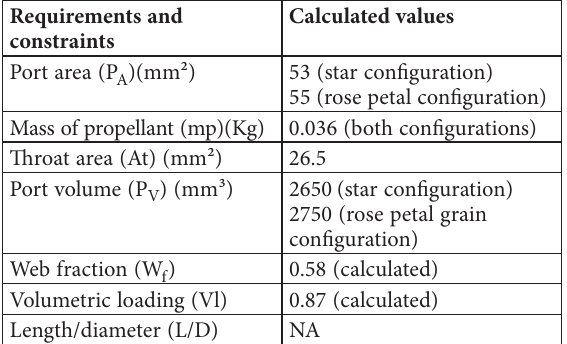
Table 2. Calculated values of requirements and constraints for case #1